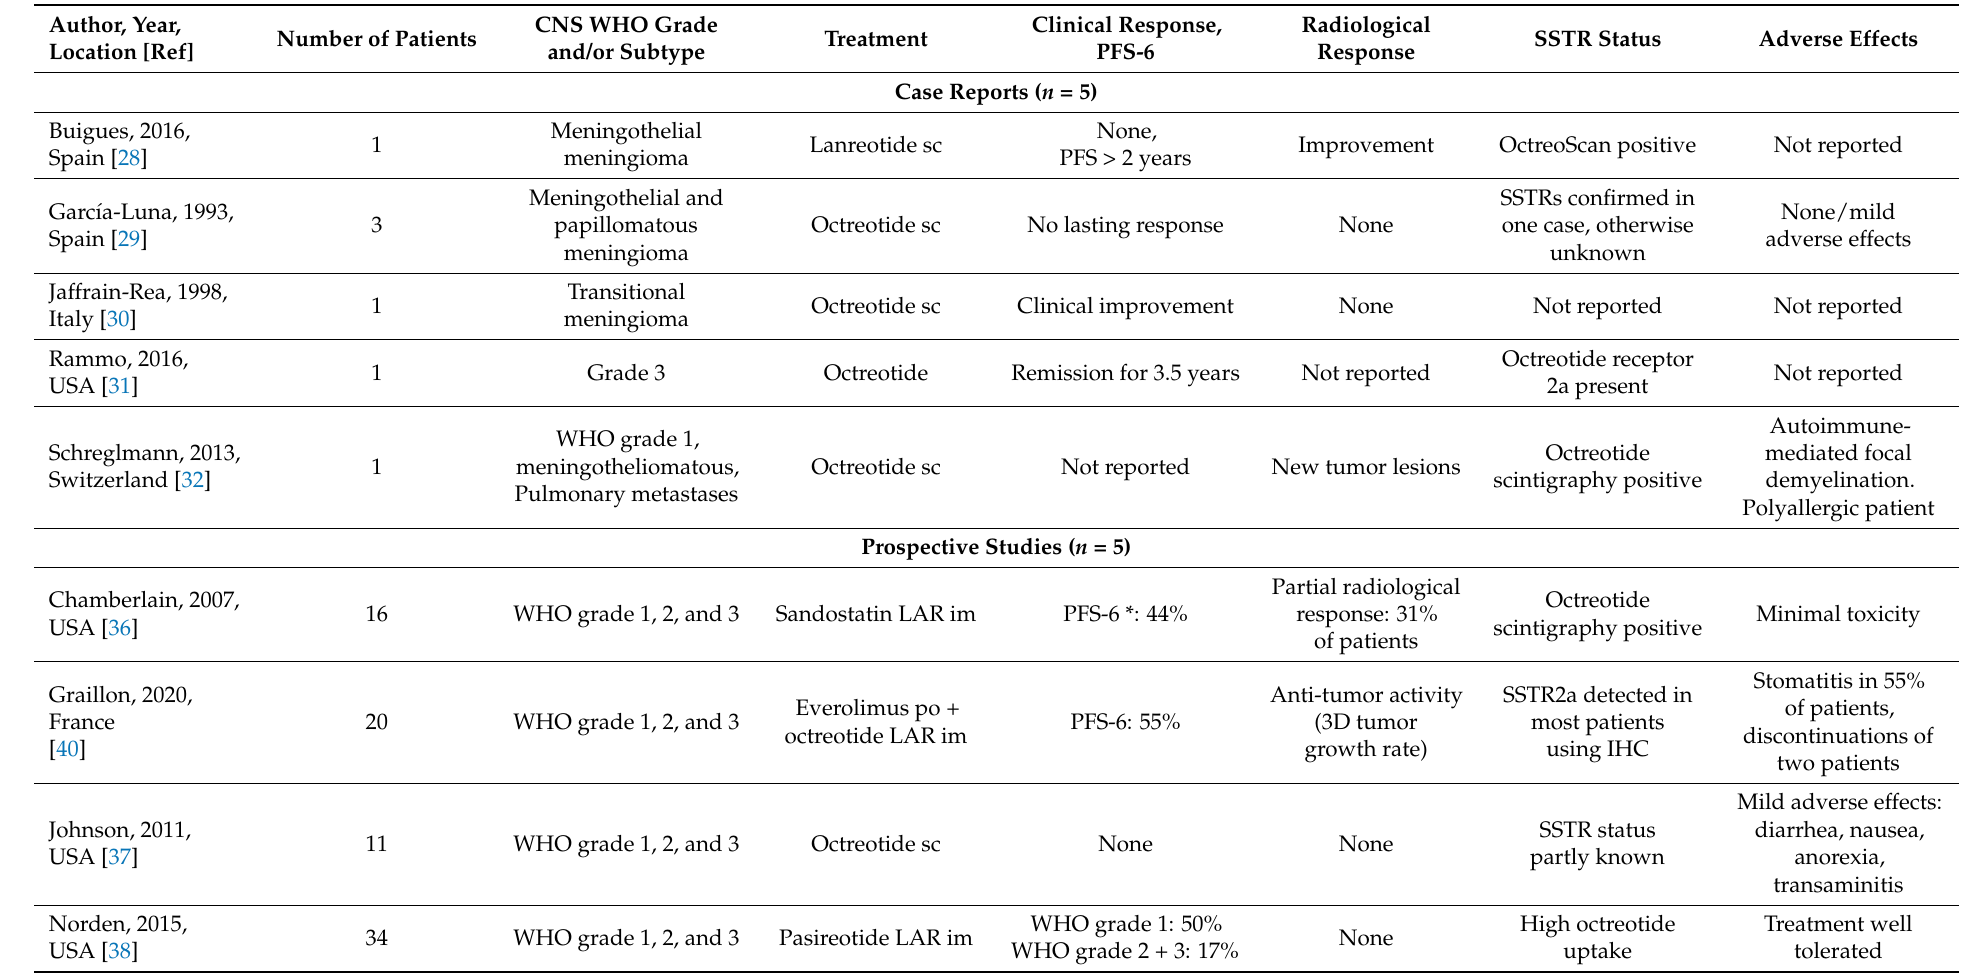
Table 1. Overview of the 13 included in vivo